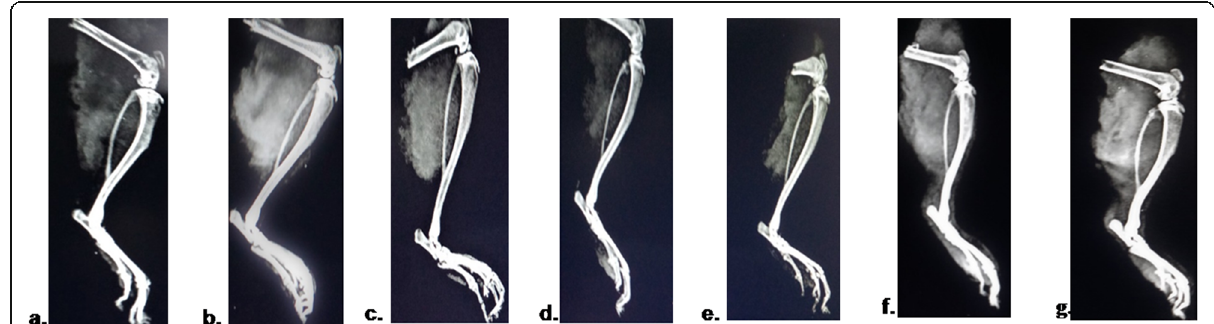
Fig. 11 Radiology of Hind Paw for various treatment groups: Where a . Normal Control (GI), b . Negative Control (GII), c . Standard group (GIII), d .